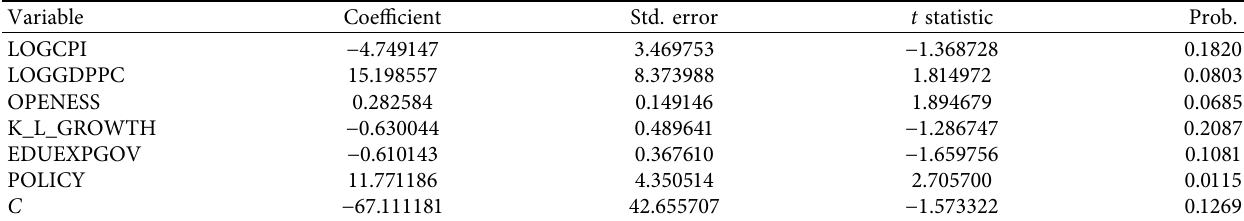
Table 6: Long-run coefficients: the dependent variable is the years of schooling.